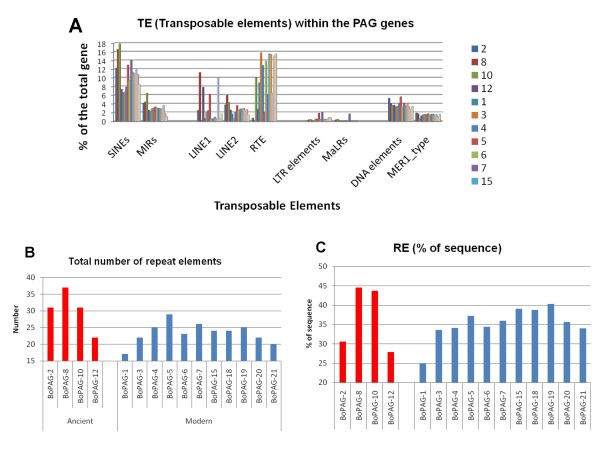
Relative distribution of non-LTR (SINE, LINE), LTR and transposable elements (TEs) within several bovine PAG genes. A. Each colored bar represents the relative distribution of the corresponding element in each boPAG gene. The TE elements were shown on the -X axis. The relative % of the sequence contributed by each element is shown on the Y-axis. The definition of the acronyms used in the figure is as follow: LTR: long terminal repeat; SINE: short interspersed element; LINE: long interspersed element; MIR: mammalian wild- interspersed repeat (sub-class of SINE); RTE: retrotransposable elements; MaLR: mammalian apparent long terminal repeat; MER: medium reiterated element. B. and C. show the cumulative total of the number of TEs, as well as the % contribution to the sequence of individual boPAGs. B: represents the cumulative total of the all the different kinds of the elements in individual PAG genes. C: shows the % make-up of the PAG genes by the TEs.